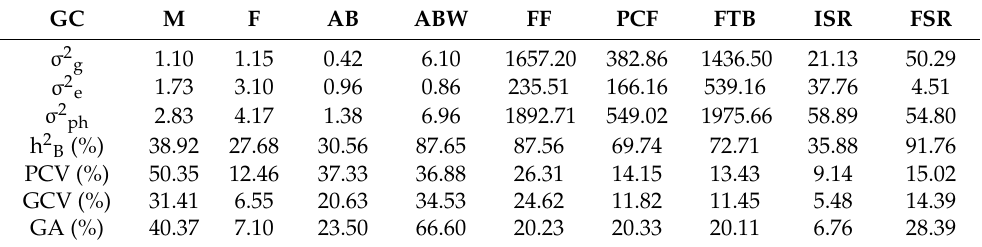
Figure 4. Mean performance of ten genetic origins for fruit types and average bunch weight per palm per year. ABW, average bunch weight; FTB, fruit to bunch; FF, fertile fruit; PCF, infertile fruit; Ag, Angola; A, AVROS (Algemene Vereniging rubber planters); N, Nigeria; C, Cameroon; DJL, Deli Johor Labis; DUR, Deli Ulu Remis; T, Tanzania; Y, Yangambi; DB, deli Banting.